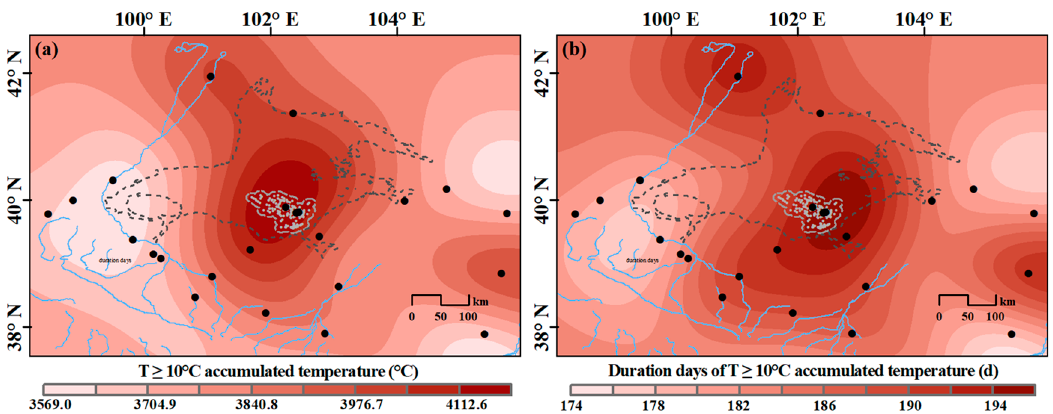
Figure 3. ( a ) Spatial distribution of T ≥ 10 °C accumulated temperature and ( b ) duration days from 2010 to 2017 over the BJD study area.